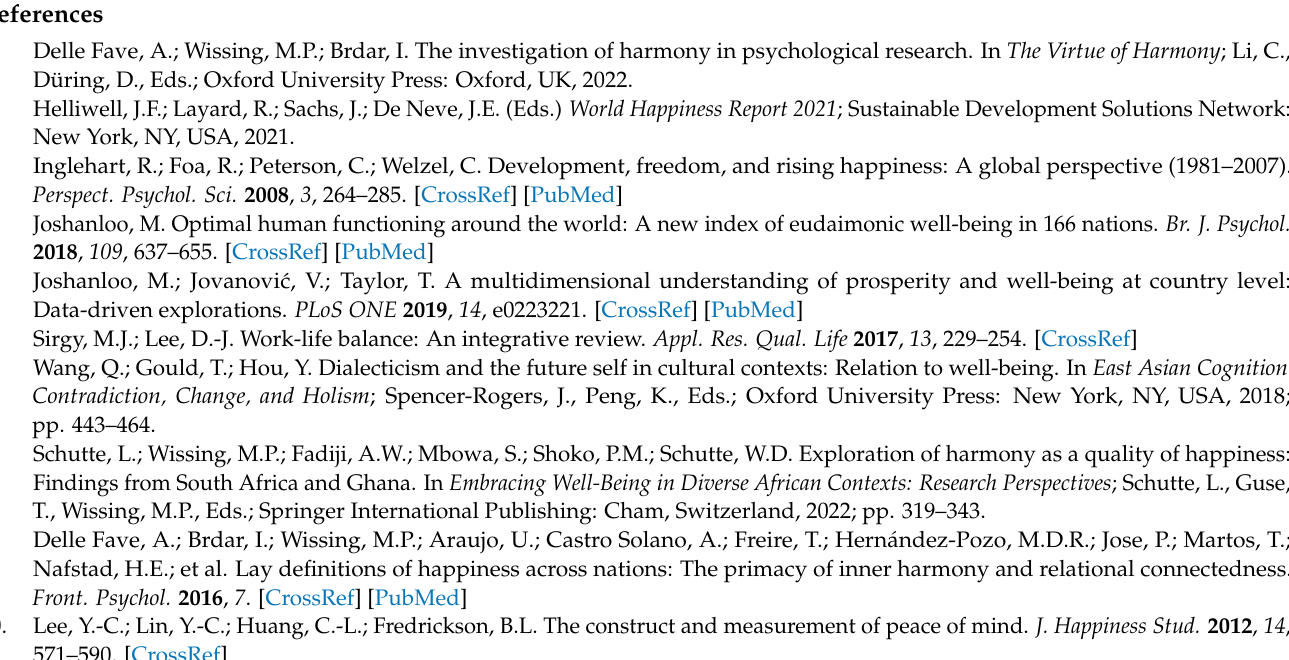
Table S2: Country Ranking for Mental Balance; Table S3: Country Ranking for Preference for Calm